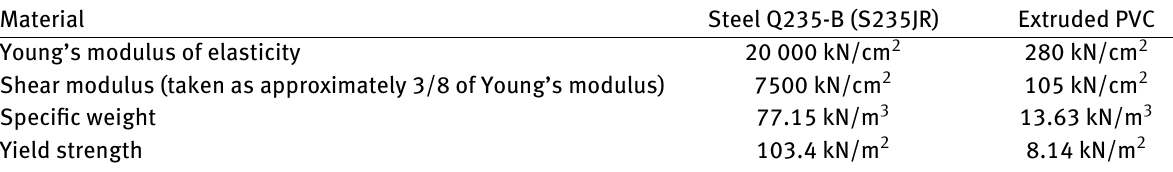
Table 3: Properties of the materials used for the structure Material